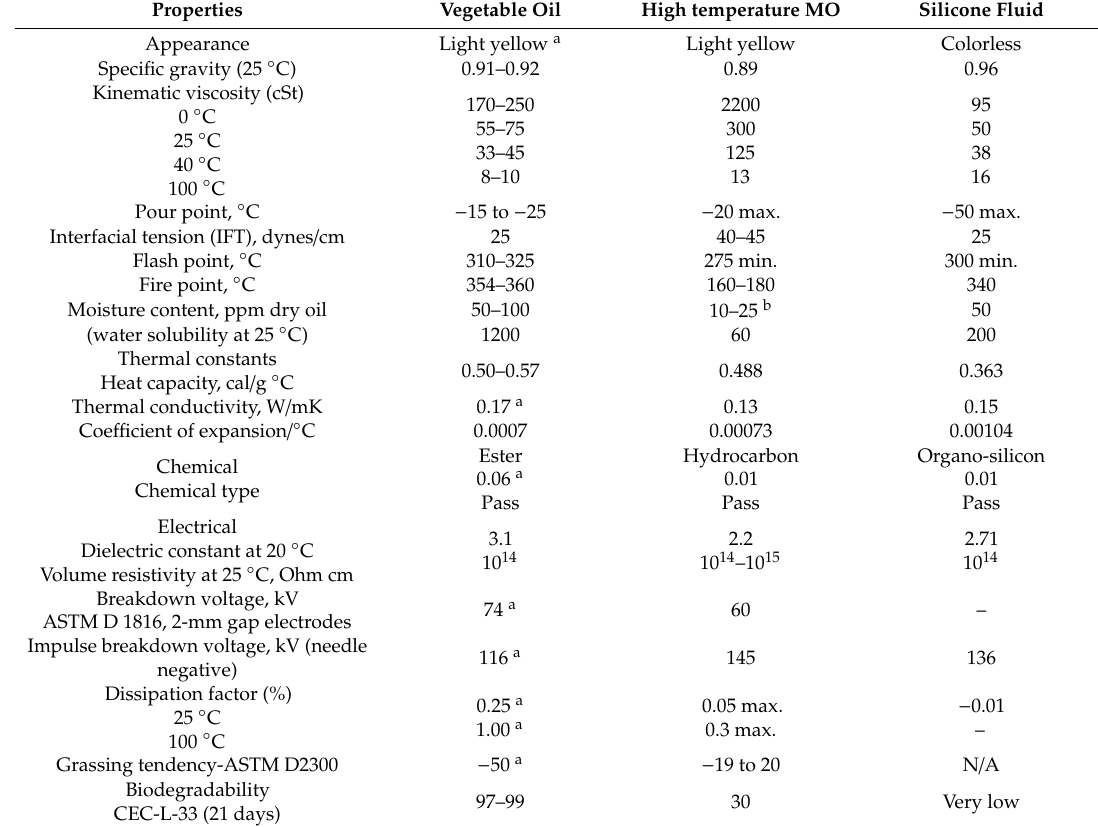
Table 18. Properties of transformer fluids (typical values / limits)